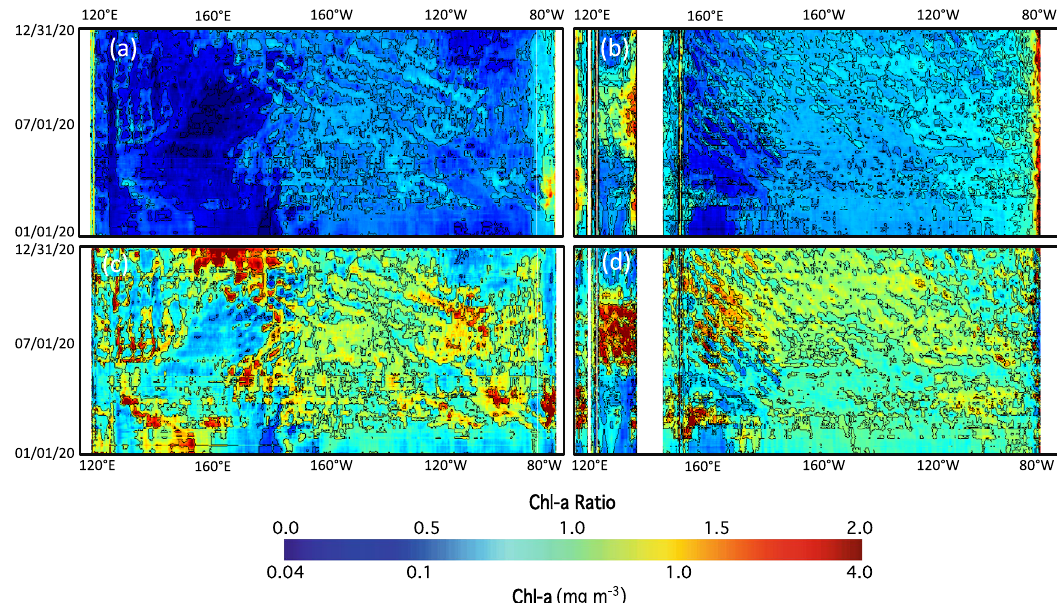
Figure 4. ( a ) Temporal change of Chl-a at 5°N between 115°E and 75°W in 2020, ( b ) temporal change of Chl-a at 5°S between 115°E and 75°W in 2020, (c) temporal change of Chl-a ratio (Chl-a/Chl-a ( Mean ) ) at 5°N between 115°E and 75°W in 2020, and (d) Chl-a ratio at 5°S between 115°E and 75°W in